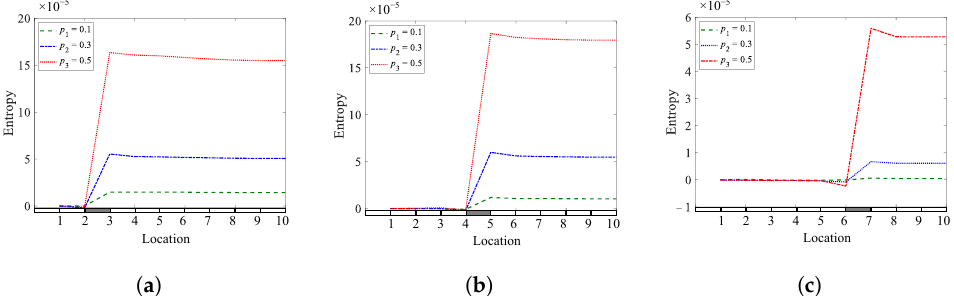
Figure 12. Entropy of a cantilever beam for different crack depths and locations: ( a ) q 1 = 0.25; ( b ) q 2 = 0.45; ( c ) q 3 = 0.65.